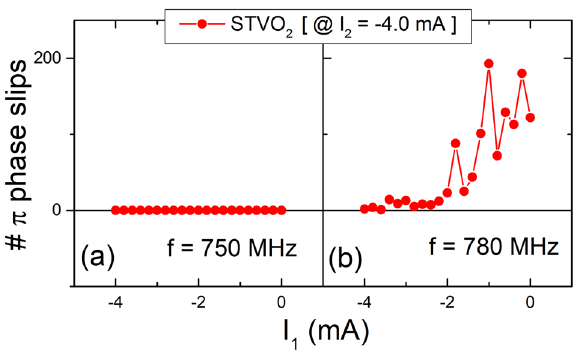
Fig. 6 Variation of the locking with the coupling between oscillators. The second harmonic injection locking (SHIL) of oscillator 2 (STVO 2 ) is calculated by its π phase slips, presented as a function of the direct current I 1 applied to oscillator 1 (STVO 1 ) for two distinct frequencies of the external signal: ( a ) 750 MHz and ( b ) 780 MHz. The direct current I 2 applied to STVO 2 is − 4.0 frequency tuned [Fig. 5c for I 1 = I 2 = − 4.0 mA] oscillations and shows the locking between each STVO and the RF signal.